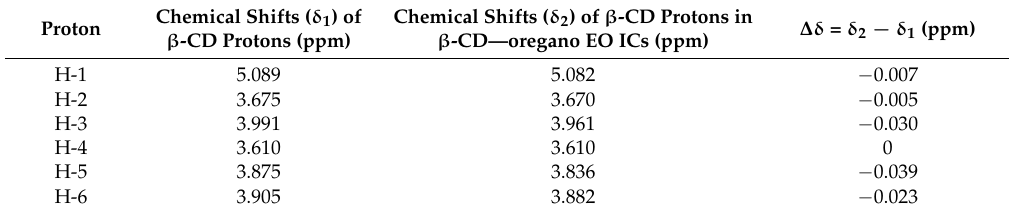
Table 2. Chemical shift changes of 1 H-NMR signals of β -CD and β -CD–oregano EO ICs.